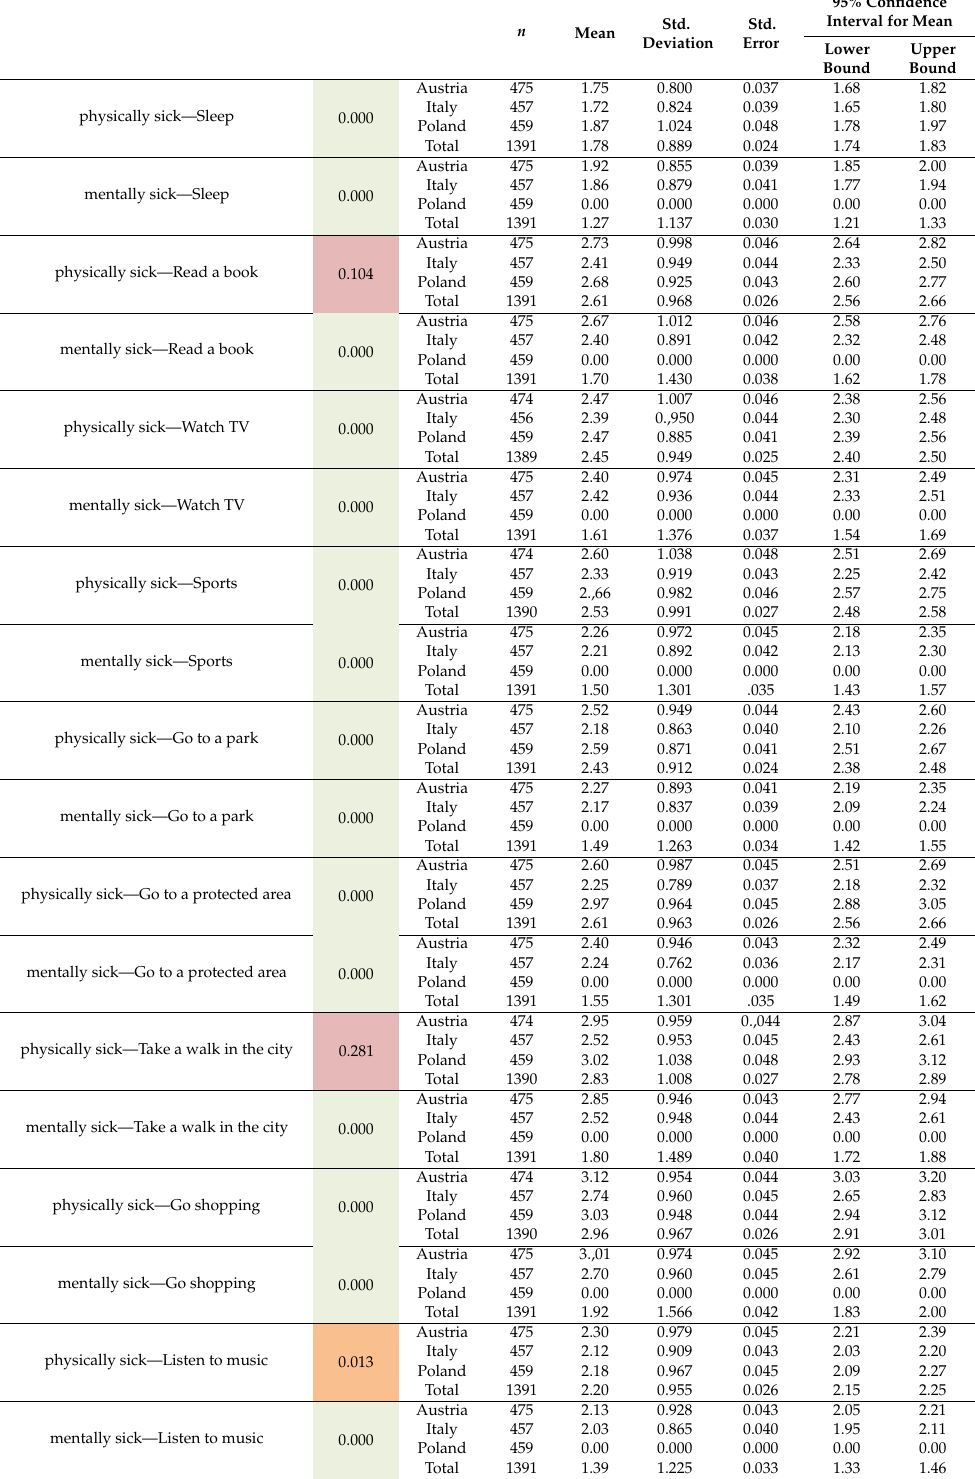
Table 6. Activities in the case of physical/mental absence of well-being and health (green = highly significant differences, orange = significant differences, red = no significant